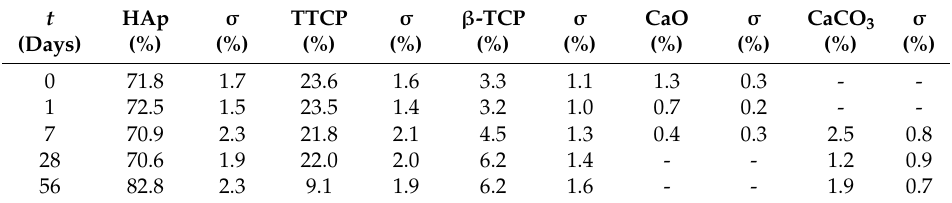
Table 3. Phase content of plasma-sprayed and incubated hydroxylapatite coatings as obtained